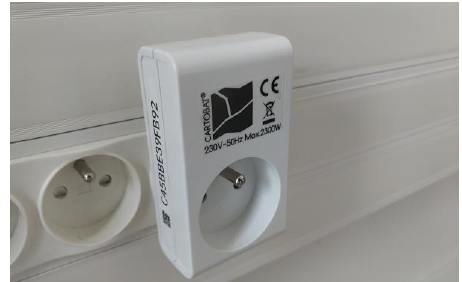
Figure 6. A plugged